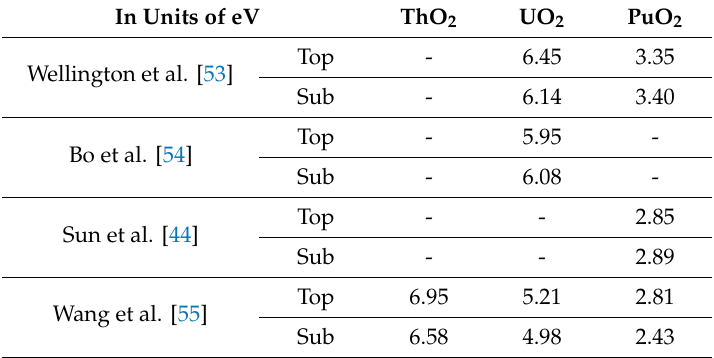
Table 4. Formation energies of top-surface and subsurface oxygen vacancy in AnO 2 (111) surfaces. In Units of